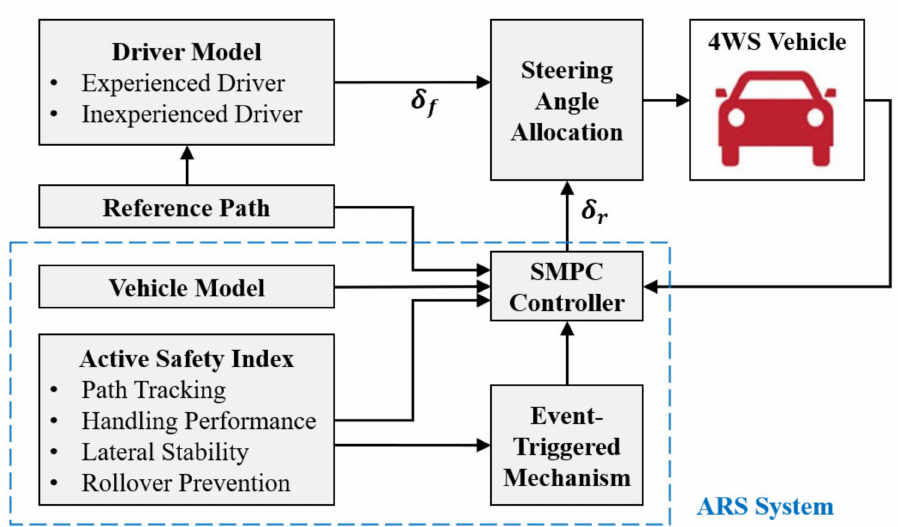
Figure 1. Control system framework of human driver and ARS